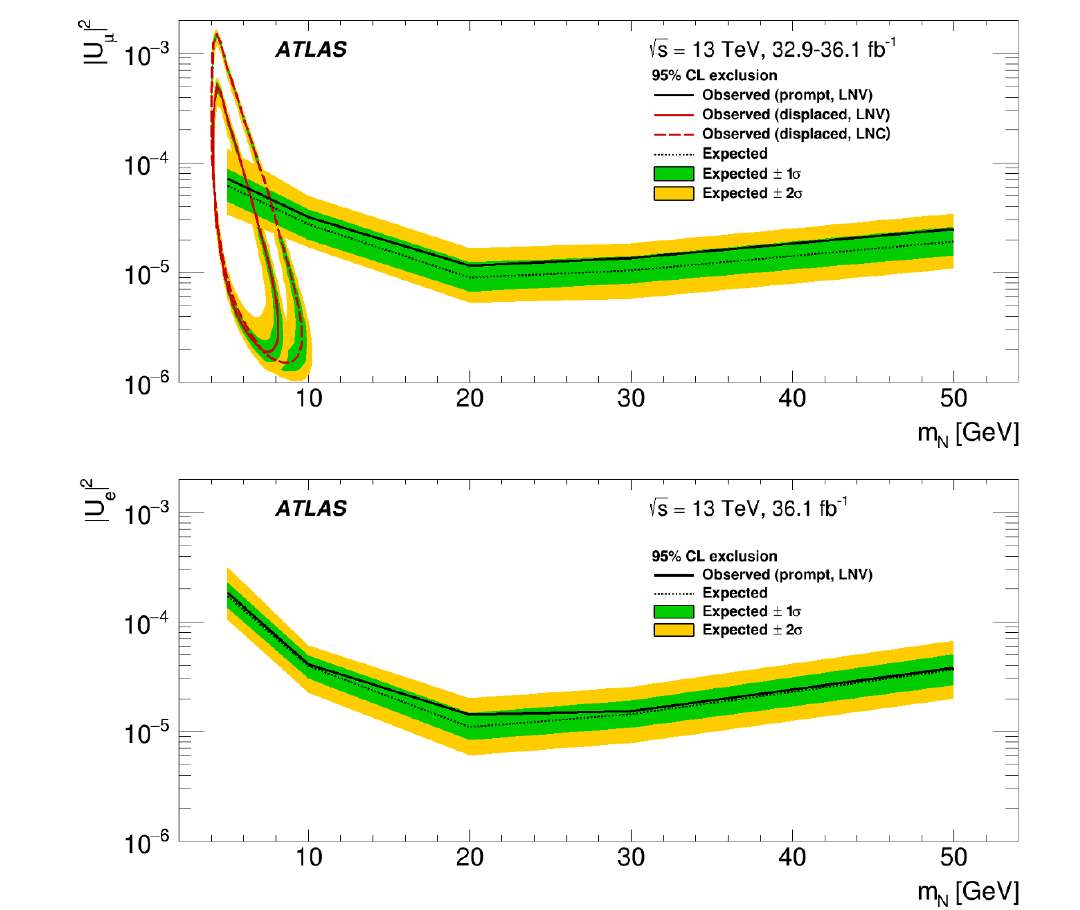
Figure 6. Observed 95% con(cid:12)dence-level exclusion in j U (cid:22) j 2 (top) and j U e j 2 (bottom) versus the HNL mass for the prompt signature (the region above the black line is excluded) and the displaced signature (the region enclosed by the red line is excluded). The solid lines show limits assuming lepton-number violation (LNV) for 50% of the decays and the long-dashed line shows the limit in the case of lepton-number conservation (LNC). The dotted lines show expected limits and the bands indicate the ranges of expected limits obtained within 1 (cid:27) and 2 (cid:27) of the median limit, re(cid:13)ecting uncertainties in signal and background